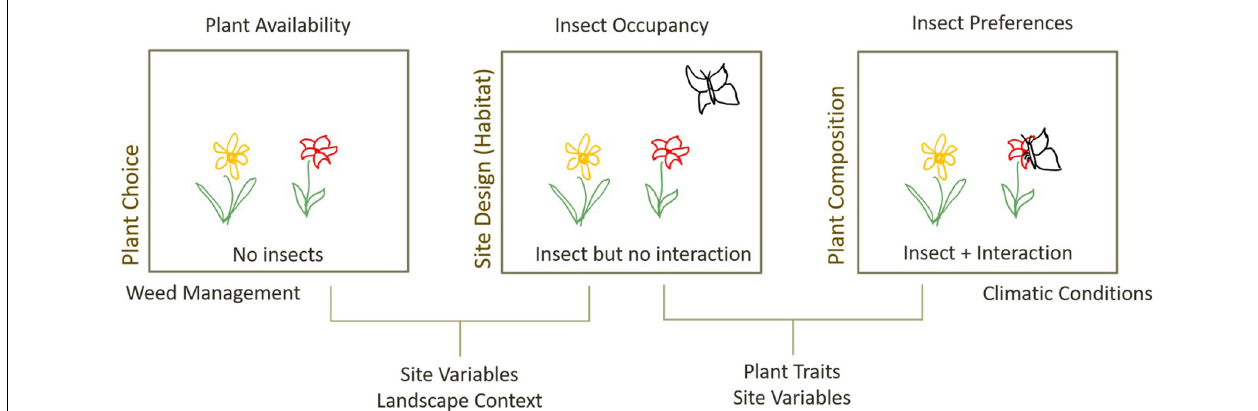
FIGURE 1 | Processes influencing plant–insect interactions in urban greenspaces, and design interventions that can influence these processes (left-hand text). Greenspace design can influence the availability of plants and insects on a site, through plant choice, design and management practices. The presence of both insect and plant does not guarantee an interaction and is influenced by the match between plant traits and insect preferences but may also be mediated by site variables that affect internal movement patterns or competition for resources, as well as climatic conditions that influence insect activity.